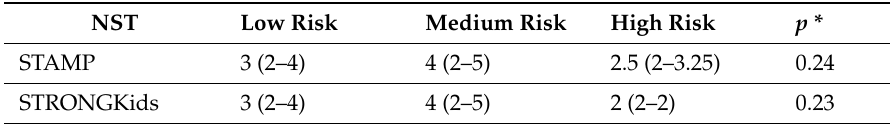
Table 4. Length of stay (median, interquartile range) in di ff erent categories of risk for both nutrition screening tools.